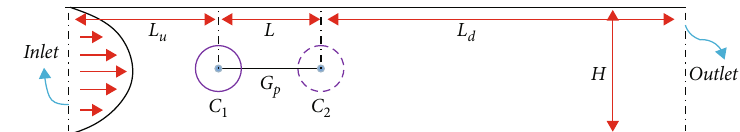
Figure 1: Schematic diagram of the problem.